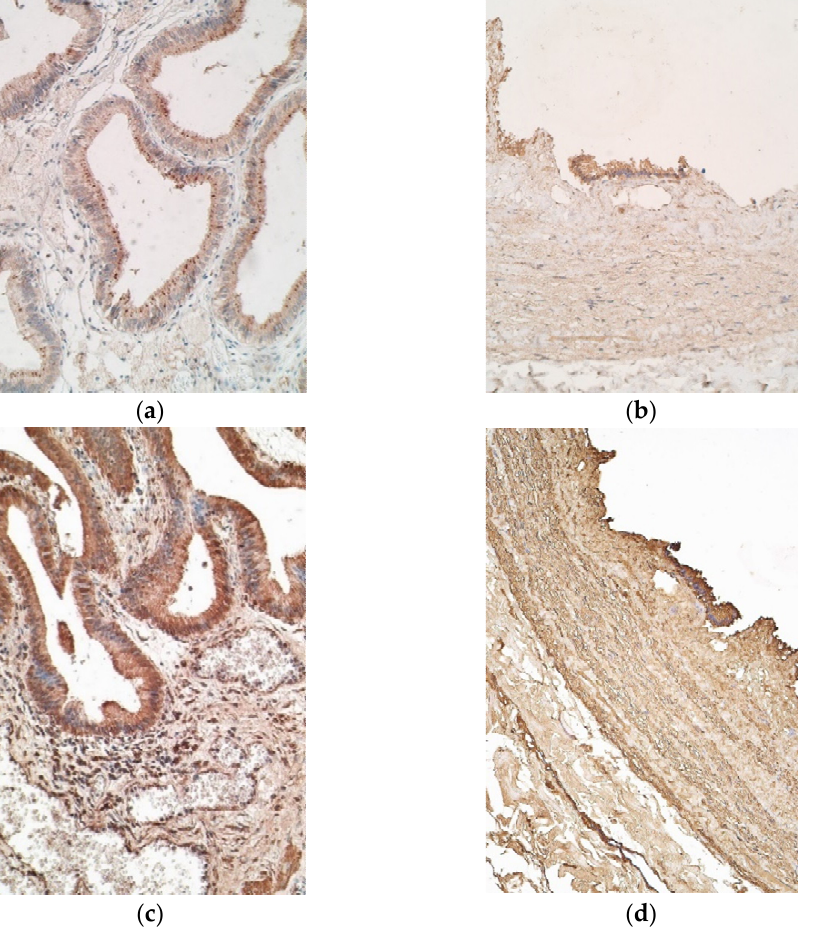
Figure 4. Micrographs of gallbladder in children with cholecystitis and in controls. ( a ) Few to moderate number of IL-10 positive epitheliocytes with absence of the factor in the connective tissue. IL-10 IMH, ×200; ( b ) few of IL-10 positive cells in the epithelium of control sample. IL-10 IMH, ×200; ( c ) numerous positive cells in the epithelium of the patient. IL-17A IMH, ×200; ( d ) epithelium of a control sample, containing numerous IL-17A positive cells. IL-17A IMH, ×200.